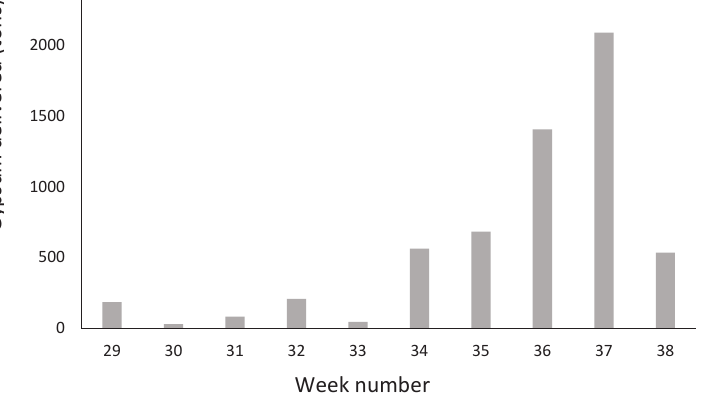
Fig. 2. Logistic challenge: weekly amounts of delivered gypsum during summer and autumn 2016 (Information source: Movere)